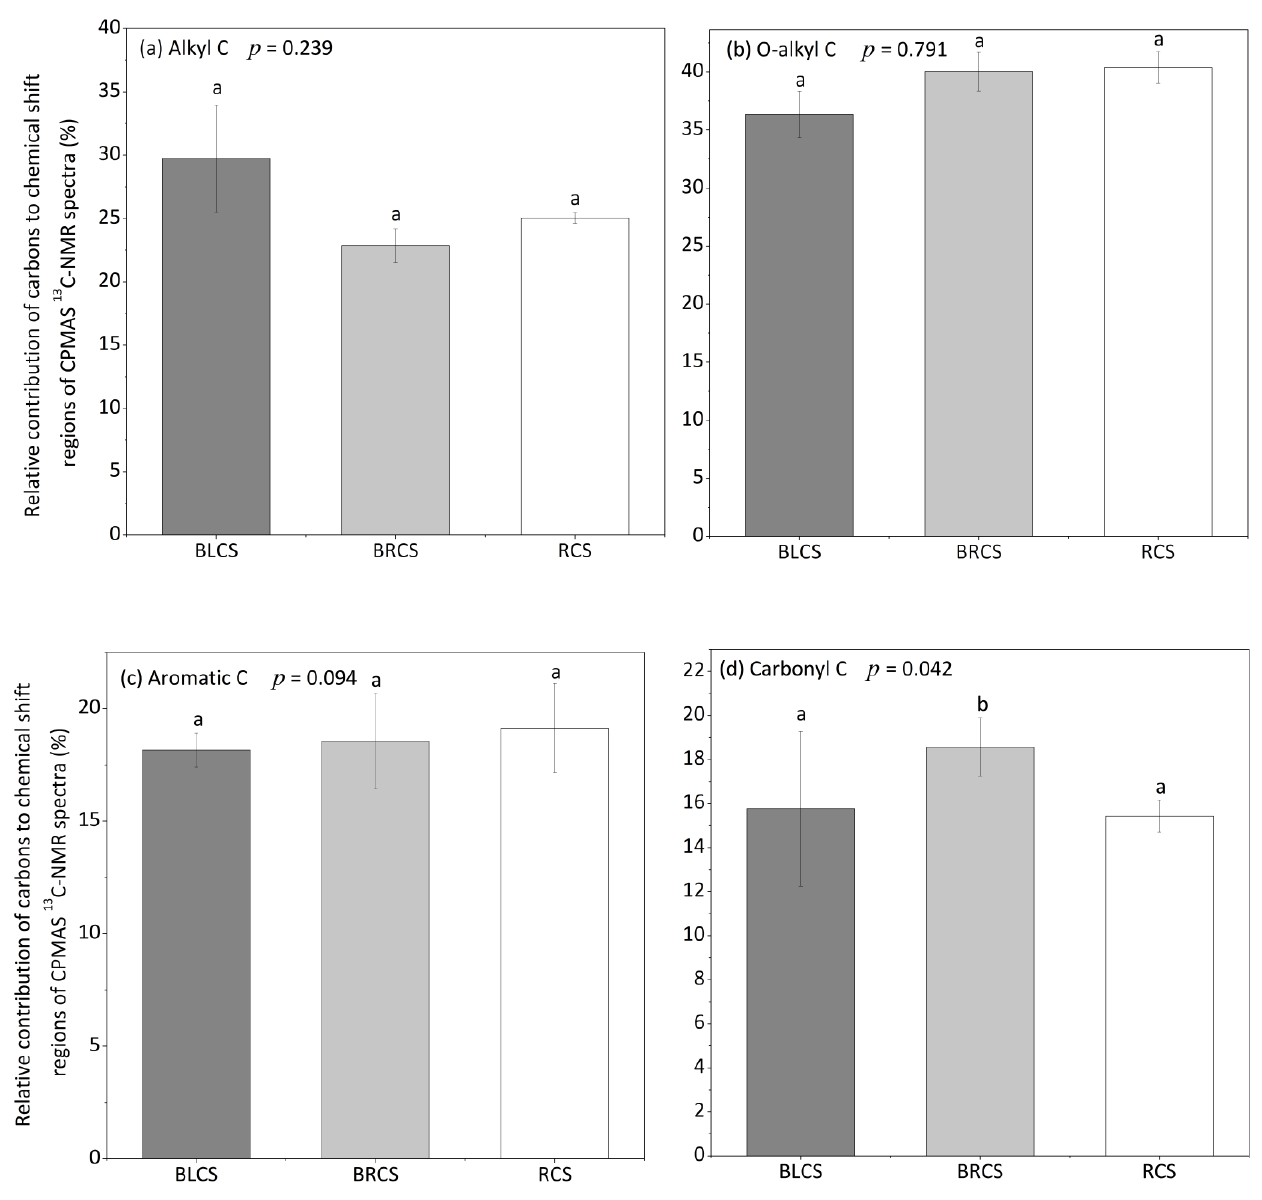
Figure 4. Relative contribution of carbons to chemical shift regions of CPMAS 13 C-NMR spectra. ( a ) Alkyl C in chemical shift regions of CPMAS 13 C-NMR spectra; ( b ) O-alkyl C chemical shift regions of CPMAS 13 C-NMR spectra; ( c ) Aromatic C chemical shift regions of CPMAS 13 C-NMR spectra; ( d ) Carbonyl C chemical shift regions of CPMAS 13 C-NMR spectra.